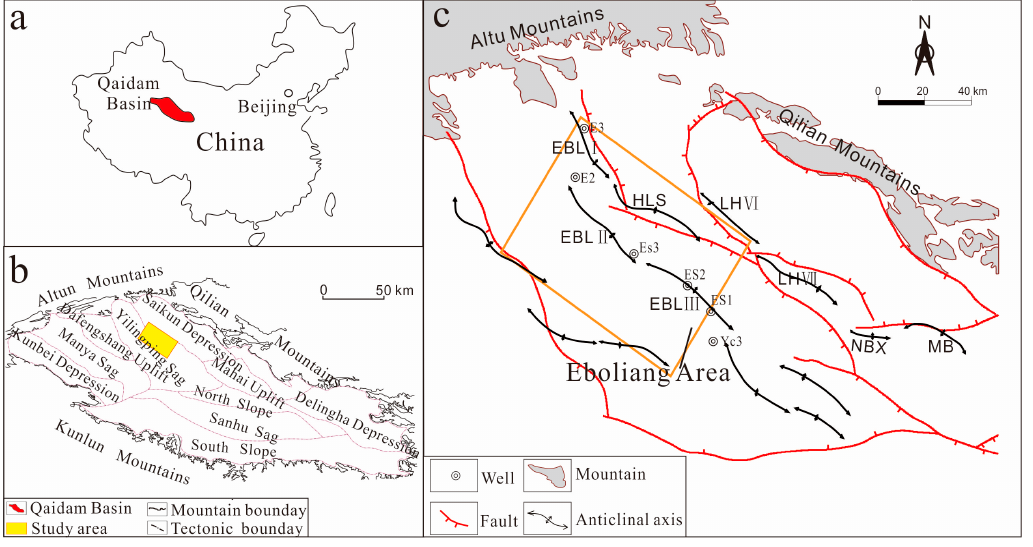
Figure 1. Sketch maps showing ( a ) location of the Qaidam Basin in NW China; ( b ) major structural units and location of the study area within the Qaidam Basin; and ( c ) tectonic structures and wells in the study area (modified after Sun [27]). EBL: Eboliang structure; LH: Lenghu structure; MB: Mabei structure; NBX: Nanbaxian structure.